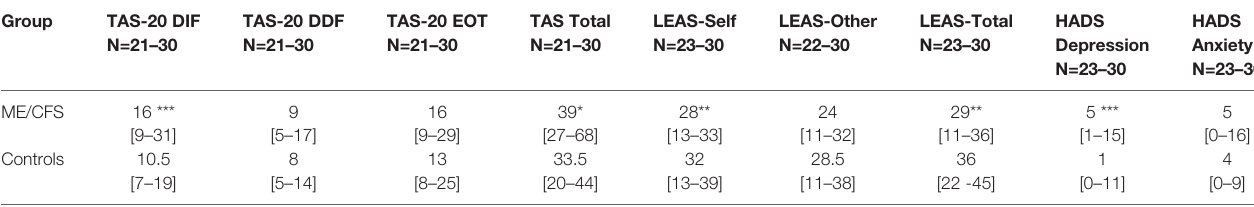
TABLE 2 | Results from three questionnaires concerning alexithymia (TAS-20), emotional awareness (LEAS) and mood (HADS) from ME/CFS patients and healthy controls.